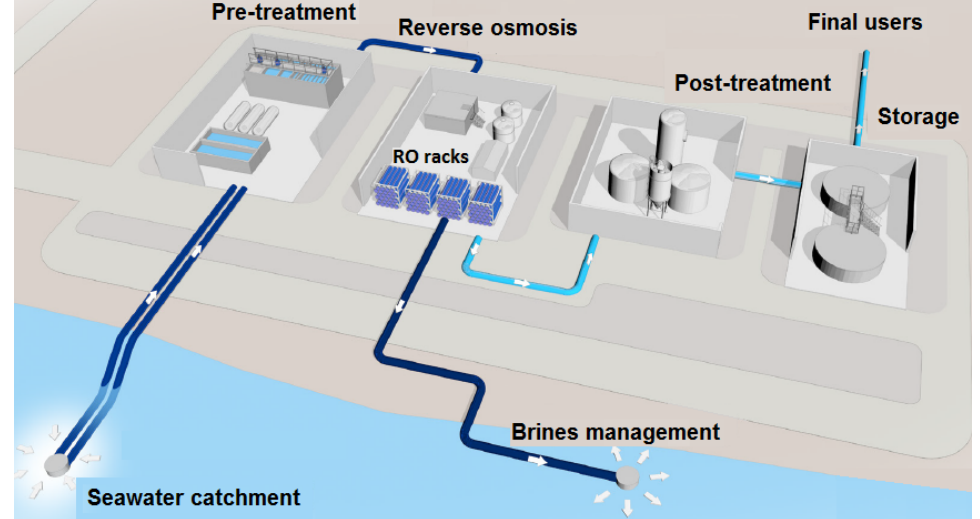
Figure 4. Diagram of the industrial seawater reverse osmosis (RO) desalination plant under study.